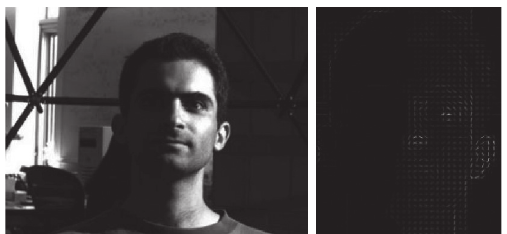
Figure 3: HOG feature of shadow on face region under light condition. It is necessary to initialize the face image because the shadow or exposure caused by complex light can affect the face region gradient